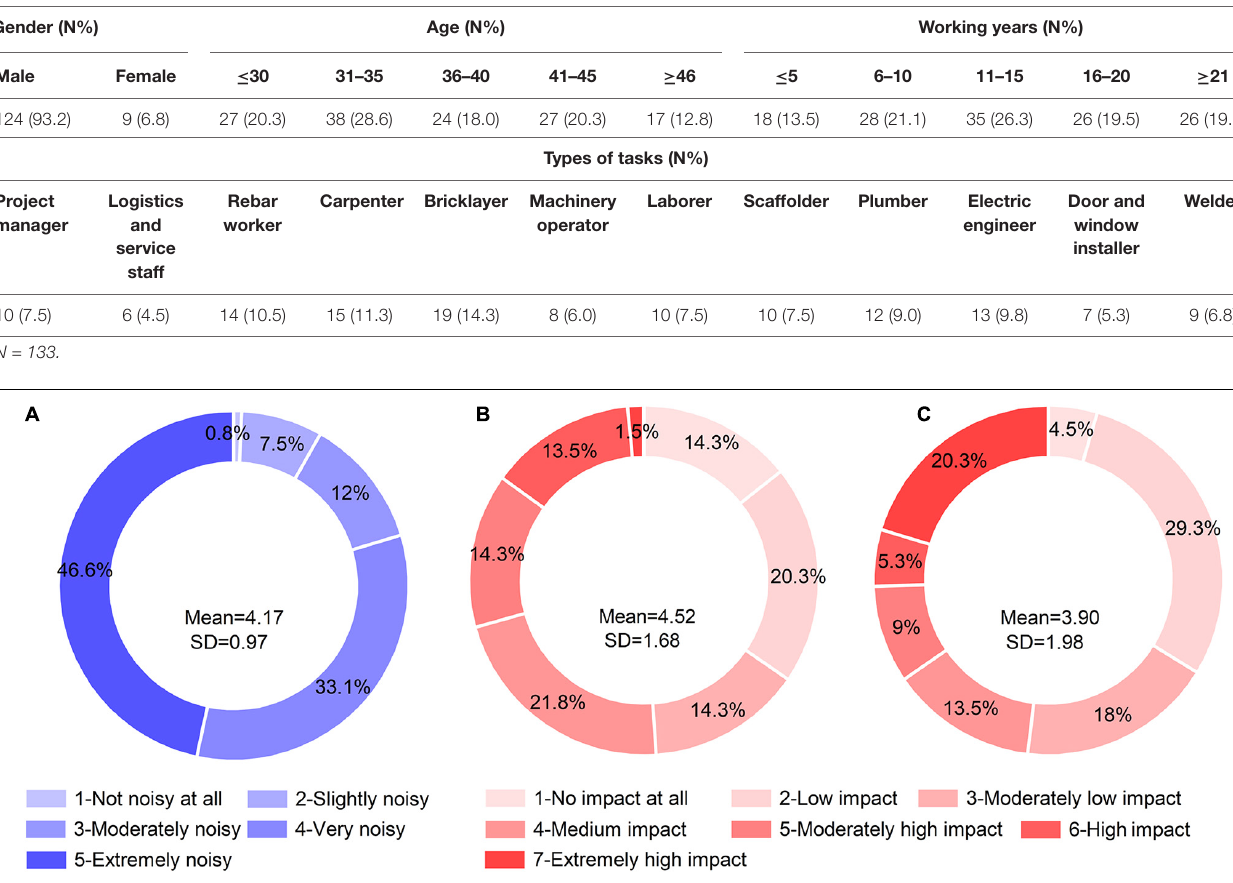
TABLE 4 | The basic characteristics for the composition of respondents.